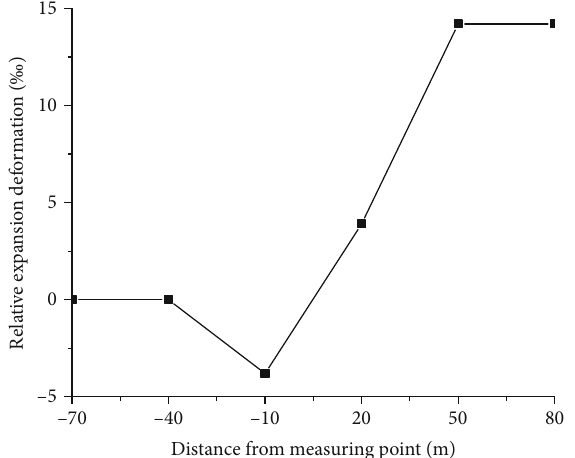
Figure 23: The variation curve for the relative expansion